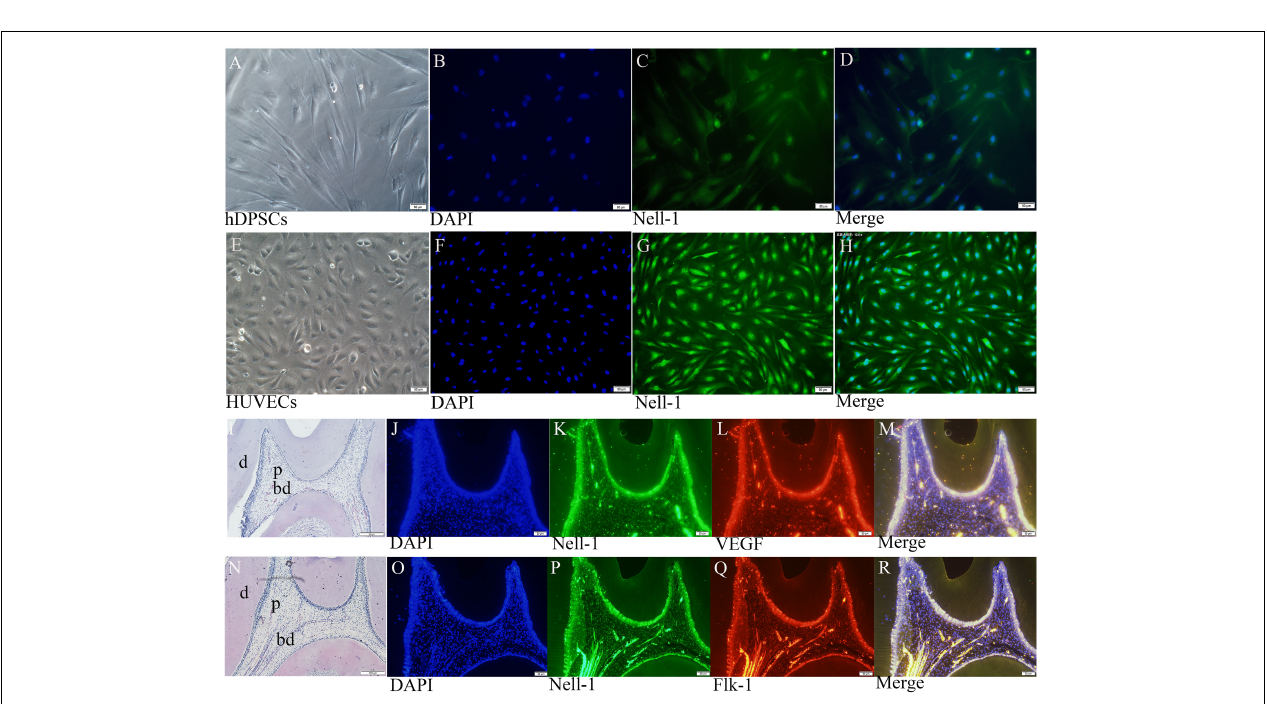
FIGURE 5 | Nell-1 distribution in DPSCs (A–D) , HUVECs (E–H) , and normal pulp tissues (I–R) . (A,E) Normal cell feature of DPSCs and HUVECs. (B,F) DAPI: nucleus stain. (C,G) green fluorescence can be observed in the nucleus of DPSCs and HUVECs. (D,H) Merged images. (I,N) HE staining displayed the morphology and structure of normal rat pulp tissues. (K,L,P,Q) Nell-1, VEGF and Flk-1 can be found in odontoblasts, pulp fibroblasts, and endothelial cells of the blood vessels. (J,O) DAPI: nucleus stain. (M,R) Merging Nell-1 with angiogenetic markers. d, dentin; p, dental pulp; bd, blood vessel.